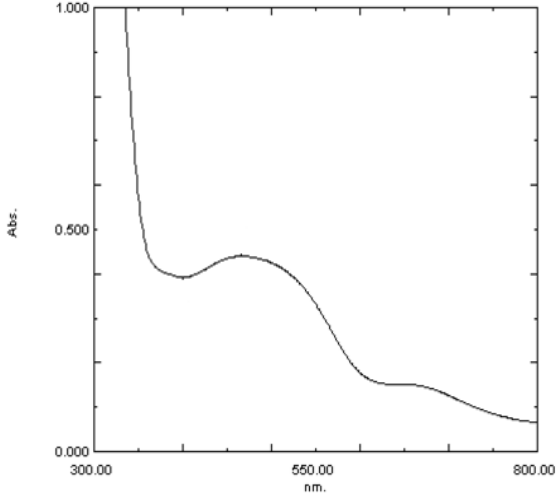
Figure 3. UV-Vis spectrum of Na